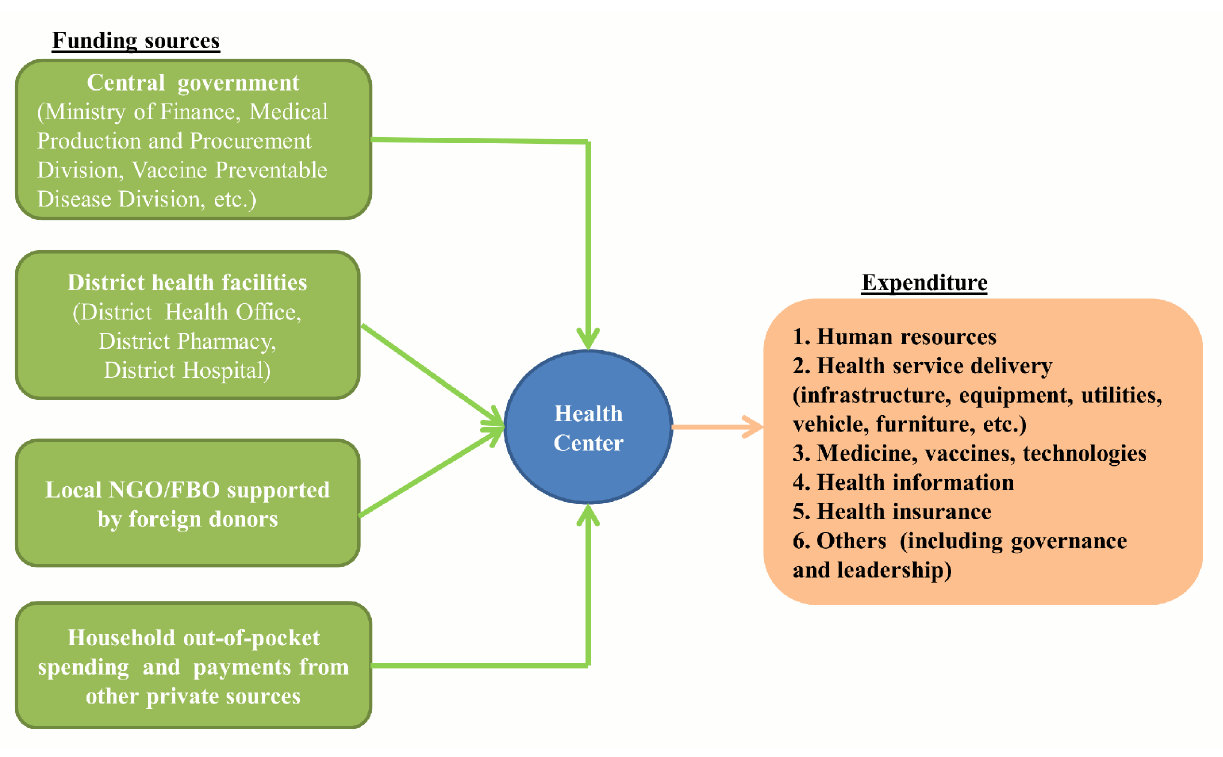
Figure 1. Channels of resource flows for health centers in Kirehe and the Southern Kayonza.